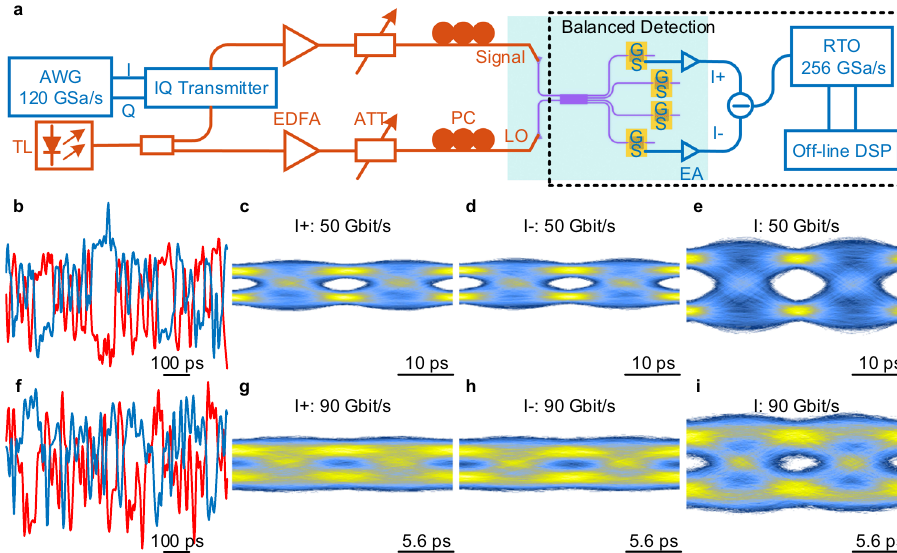
Fig. 4 Balanced detection testing. a Measurement setup for the balanced detection. AWG: arbitrary waveform generator, TL: tunable laser, EDFA: erbium- doped fi ber ampli fi er, PC: polarization controller, ATT: optical attenuator, EA: electric ampli fi er, RTO: real-time oscilloscope. b , f The real signal waveforms of 50 Gbit/s ( b ) and 90 Gbit/s ( f ) BPSK signals (blue line stands for I + branch and red line stands for I − branch). c – e Eye diagrams of I + branch ( c ), I − branch ( d ), and balanced detection ( e ) for 50 Gbit/s BPSK signal. g – i Eye diagrams of I + branch ( g ), I − branch ( h ), and balanced detection ( i ) for 90 Gbit/s BPSK